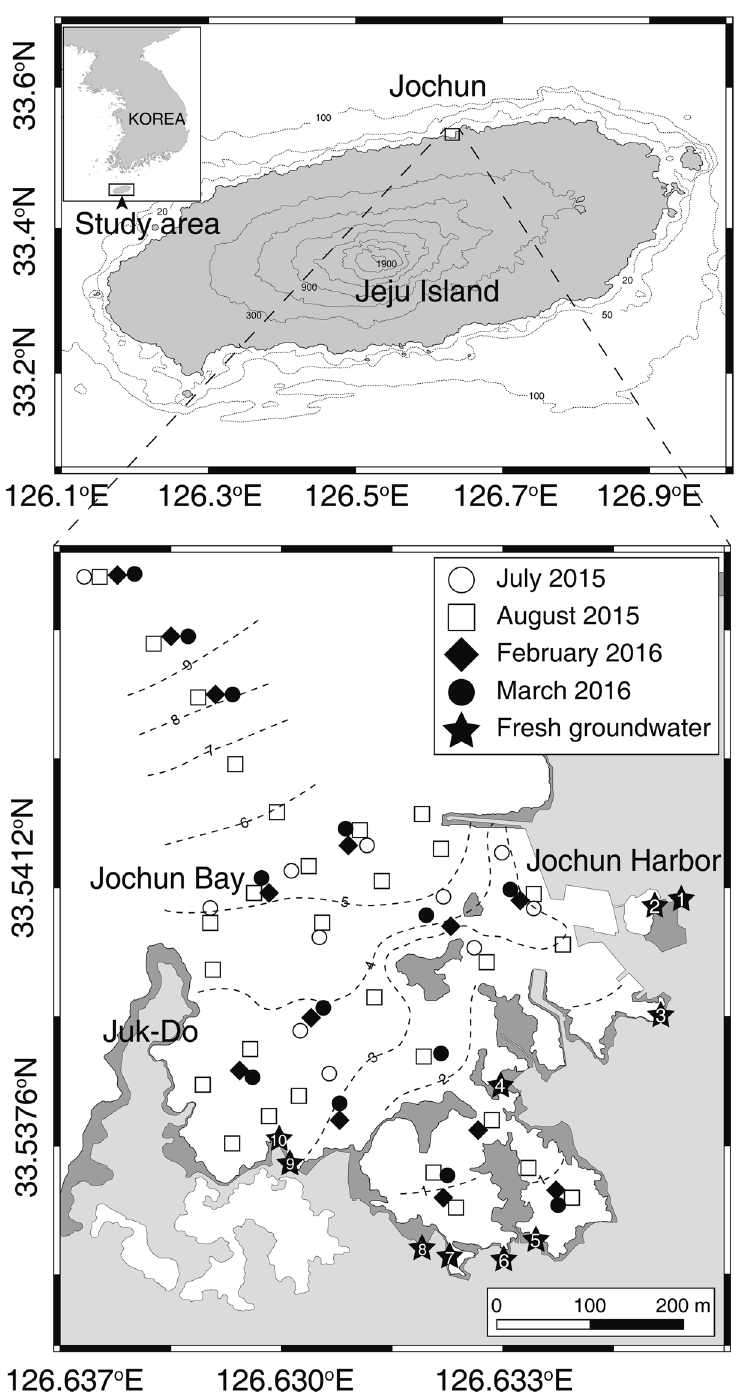
Figure 1. A map showing the study region and the sampling locations for DOC and FDOM in Jochun Bay in Jeju Island, Korea. Contour lines indicate the bottom depth based on in situ CTD casting. The number in the asterisk indicates the sampling station of the coastal spring well for the fresh groundwater. The maps and the sampling stations were drawn using Adobe Illustrator CC software version 2015.0.1.